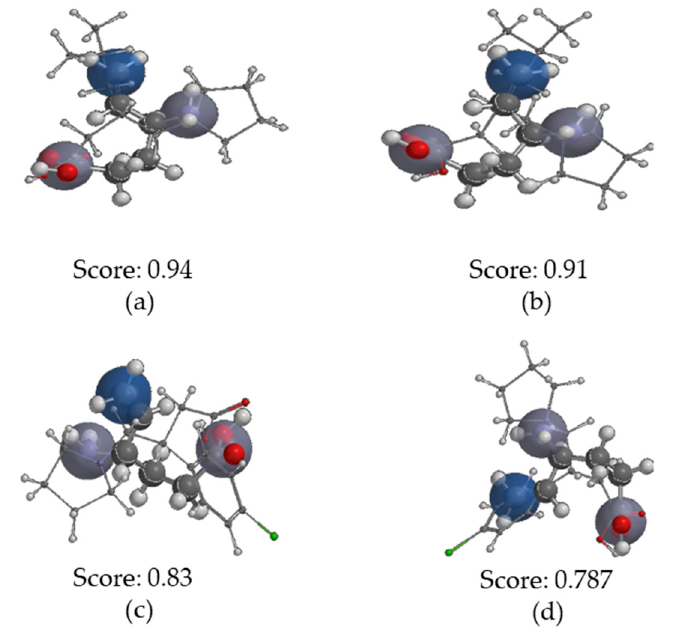
Figure 7. Structure alignment based on the CFD’s of VGB 4 in minimum energy conformation, with the active analogues. The spheres represent the CFDs. ( a ) ( S )- 18a ; ( b ) ( R )- 18a ; ( c ) ( S )- 19a ; ( d ) ( R )- 19a .